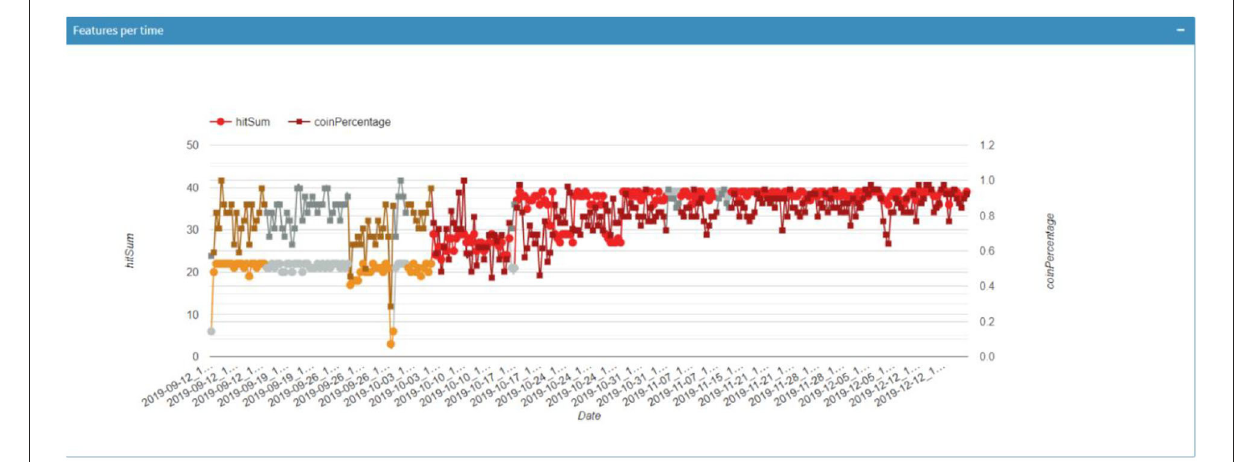
FIGURE12 Progress of variables vs. time.